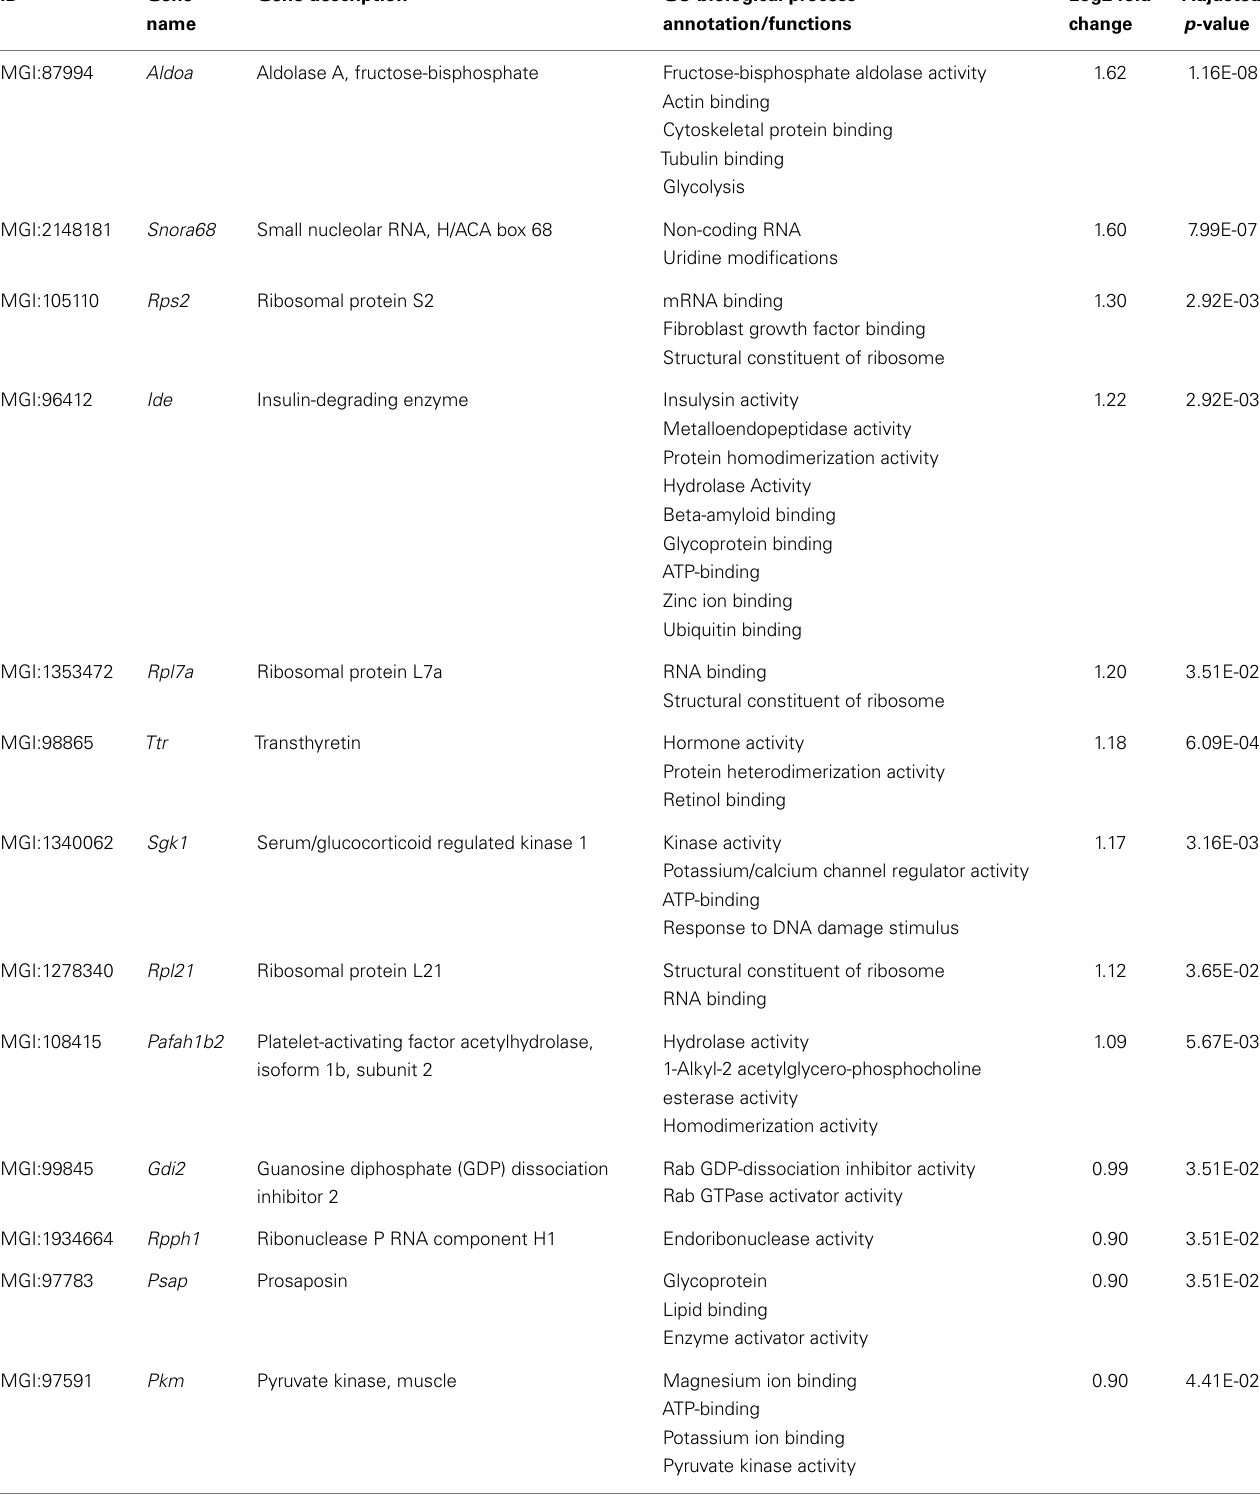
Table 2 | List of differentially expressed transcripts in young 5XFAD